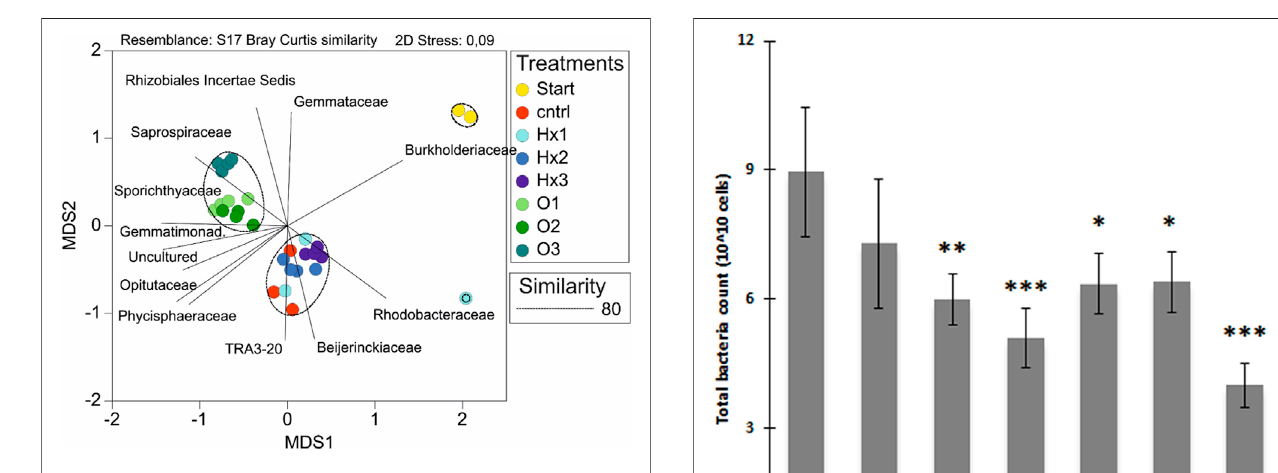
FIGURE 3 | Multidimensional scaling (MDS) of the microbial community compositions of the treatments showed signi fi cant separation of samples as the 2D stress value was < 0.1. Treatments are separated by the color and the shading of the same base color separates the dose of the individual PFCA. Moreover, the circles indicate the clustering of samples sharing similar microbial community structures under 80% similarity assumption and lines represent thefamilieswhich most strongly explained the structural differences in microbial communities between treatments (Pearson correlation threshold value 0.8).